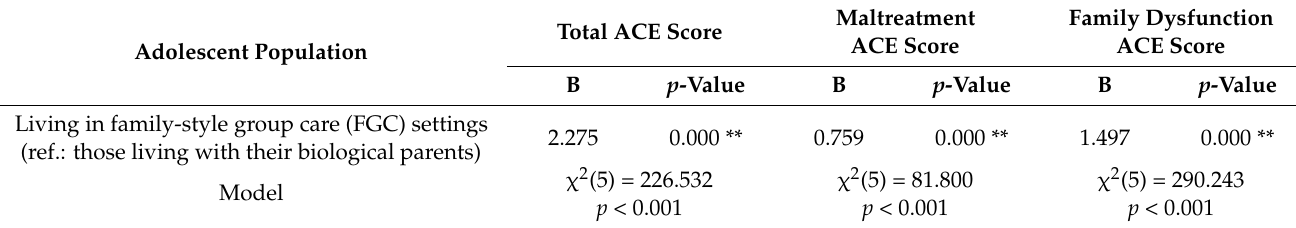
Table 3. Differences in total ACE score, maltreatment and family dysfunction ACE score between adolescents living in family-style group care (FGC) settings and adolescents living with their biological parents. Adolescent Population Living in family-style group care (FGC) settings (ref.: those living with their biological parents)